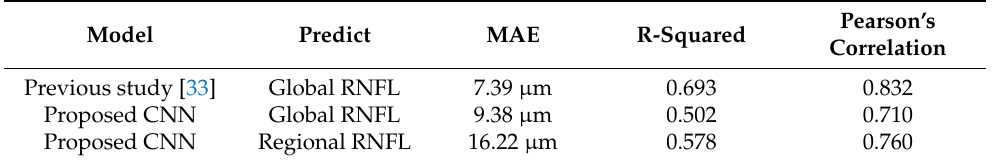
Table 2. A summary of performance metrics. The mean-absolute-error (MAE), the R-squared, and the Pearson’s correlation coefficient between prediction of RNFL from trained models and true OCT-measurements.